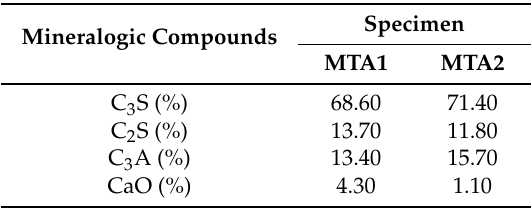
Table 2. Amount of main crystalline compounds present in MTA cements assessed by the Rietveld